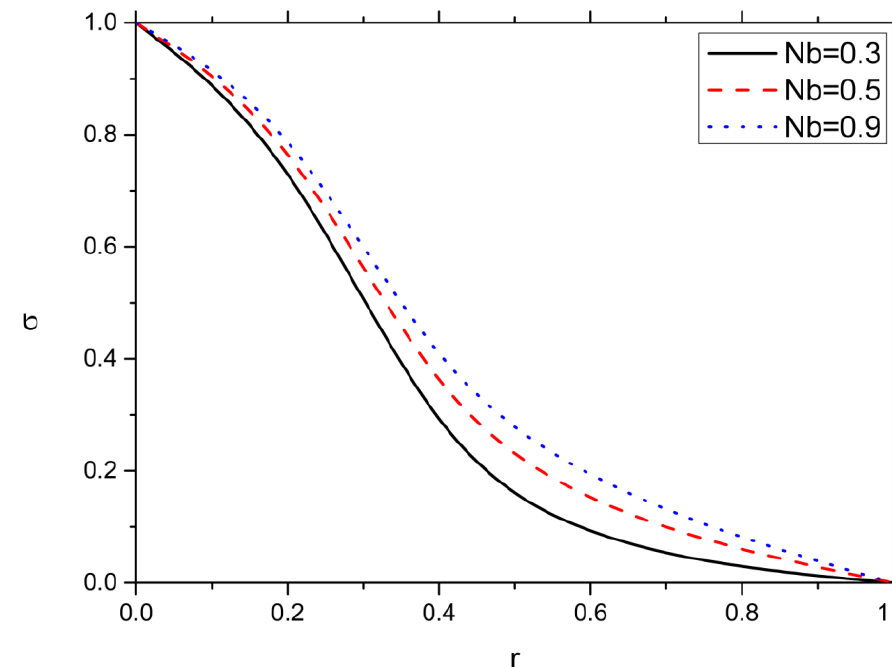
Fig. 5(a). Concentration (  ) contrary to r with  =0.17,